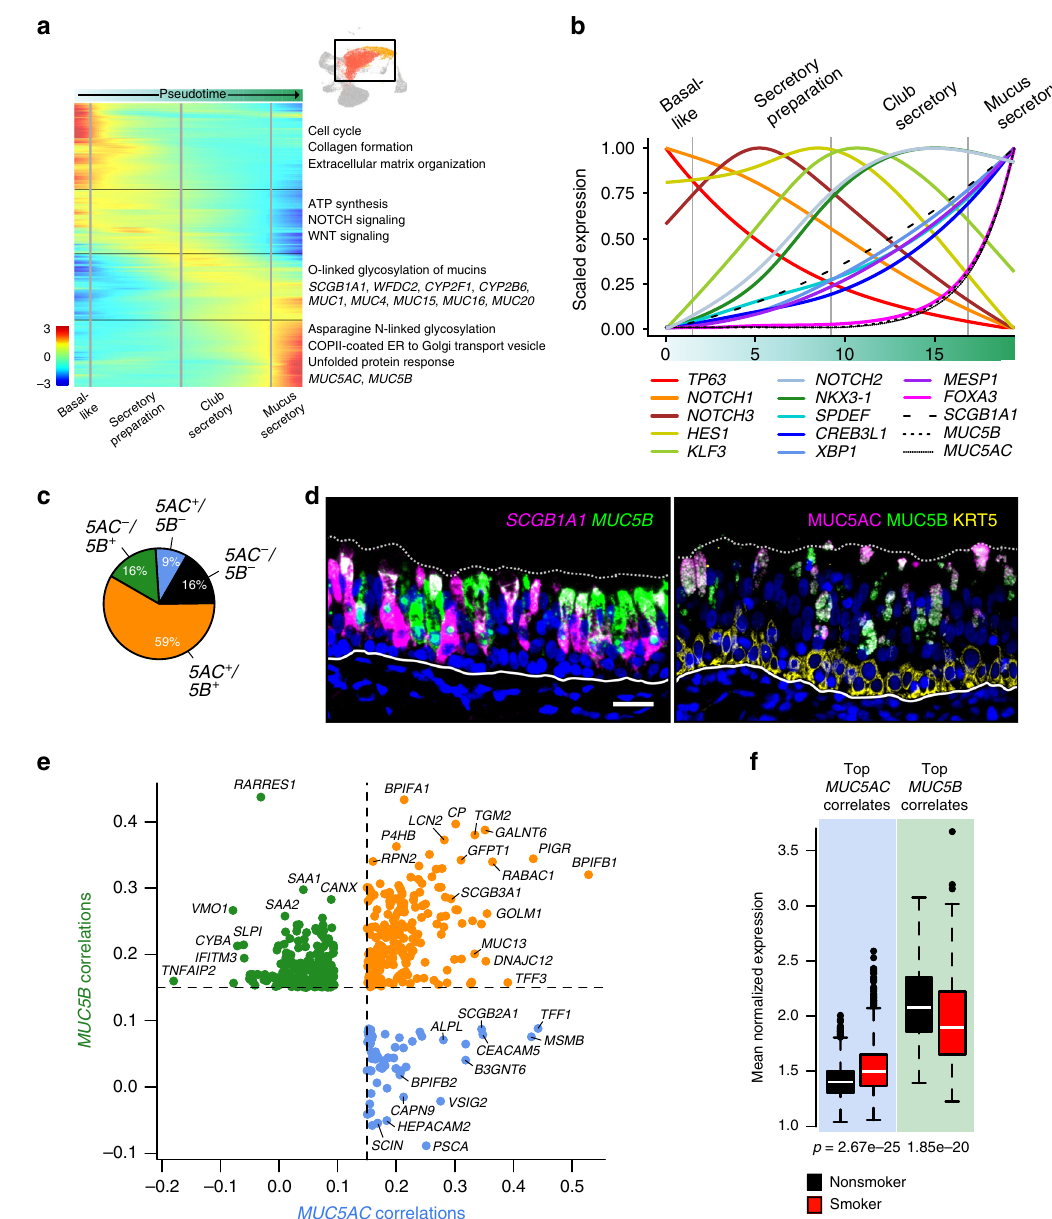
Fig. 3 In vivo secretory cells form a continuous lineage and exhibit MUC5AC-correlated smoking effects. a Heat map of smoothed expression across a Monocle-inferred lineage trajectory shows transitions in transcriptional programs that underlie differentiation in the in vivo human airway epithelium, from basal-like pre-secretory ( KRT8 high ) cells into mucus secretory cells. Select genes that represent these programs are shown, all signi fi cantly correlated with pseudotime. Key enrichment pathways and genes belonging to each block are indicated at right. b Scaled, smoothed expression of select transcriptional regulators (colored lines) and canonical markers (black dashed/solid lines) across pseudotime differentiation of human tracheal secretory cells in vivo. The x axis corresponds to the x -axis in a . c Pie chart depicts proportions of mature mucus secretory cells exhibiting different MUC5AC and MUC5B mucin co- expression pro fi les. d Co-expression of common secretory markers at the mRNA level (left, FISH with SCGB1A1 in magenta, MUC5B in green) and protein level (right, IF labeling with MUC5AC in magenta, MUC5B in green and KRT5 in yellow). In both images, overlaid magenta/green appears as white. Dashed and solid lines represent the apical edge and basement membrane of the epithelium, respectively. Scale bar = 25 μ m. e Smoking-independent correlation coef fi cients of MUC5B -correlated and MUC5AC -correlated genes. Genes are colored based on whether they were signi fi cantly correlated with only MUC5B (green), only MUC5AC (blue), or both (orange). Only the strongest correlations are plotted (correlations > 0.15), select genes are labeled. f Box plots illustrate the converse effects of smoking on the mean expression of the top 25 MUC5B- and MUC5AC -speci fi c correlated genes in mature mucus secretory cells ( n = 713 non-smoker cells, n = 886 smoker cells). Box centers give the median, upper and lower box bounds correspond to fi rst and third quartiles, and the upper/lower whiskers extend from the upper/lower bounds up to/down from the largest/smallest value, no further than 1.5× IQR from the upper/ lower bound (where IQR is the inter-quartile range). Data beyond the end of whiskers are plotted individually. p -values are from one-sided Wilcoxon tests. See also Supplementary Fig.